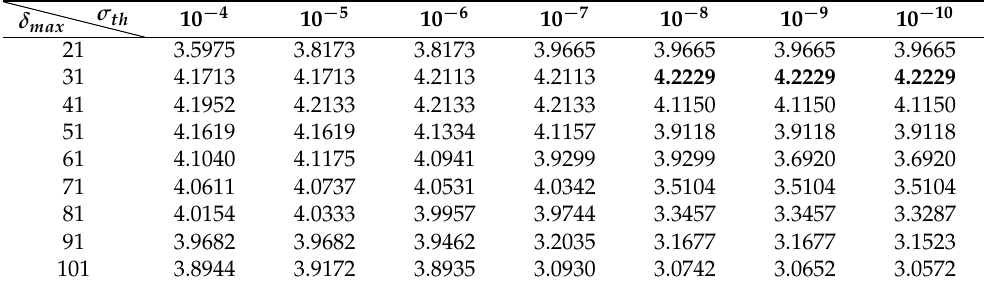
Table 3. The estimated multi-spectral fractal dimension (MFD) of multi-spectral fractal image with medium generated complexity ( H = 0.5).